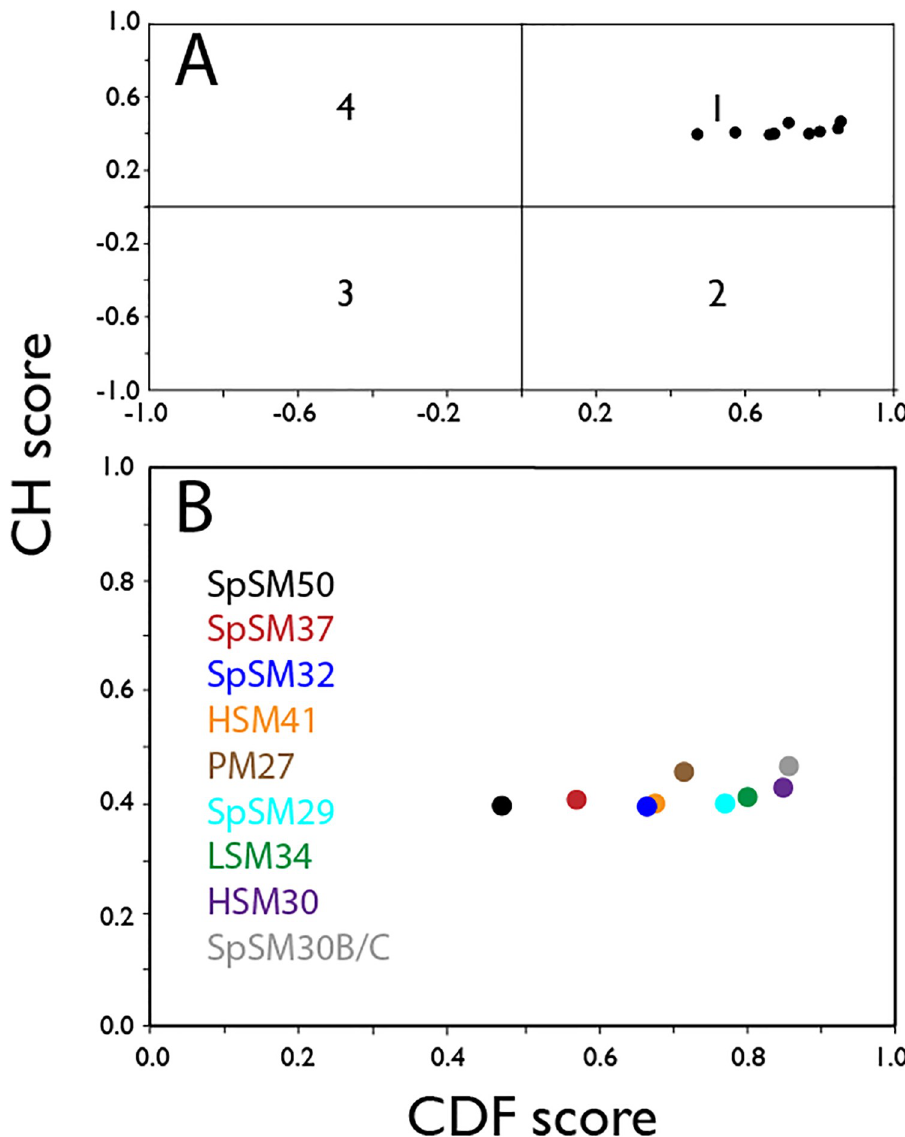
Fig 5. (A) Four quadrant (1–4) CH-CDF plot for spicule matrix protein sequences. (B) Enlargement of relevant Quadrant 1. The Y-coordinate in the CH-CDF plot corresponds to the distance from the obtained ordinate value to the correlation line separating the structured and unstructured conformational state of the protein on the CH (charge- hydrophobicity) plot. The X-coordinate on the CH-CDF plot corresponded to the distance from the obtained ordinate value to the correlation line separating the structured and unstructured conformational state of the protein in the CDF. There are 4 quadrants: Quadrant 1 (CH > 0, CDF > 0) representing rare proteins for which it is impossible to determine accurately the state, i.e., their CDF scores correspond to structured domains but CH scores correspond to unstructured proteins. Quadrant 2 (CH > 0, CDF < 0) represents unfolded proteins (U), Quadrant 3 (CH < 0, CDF < 0) represents the molten globule state (MG). Quadrant 4 (CH < 0, CDF > 0) represents structured or folded proteins